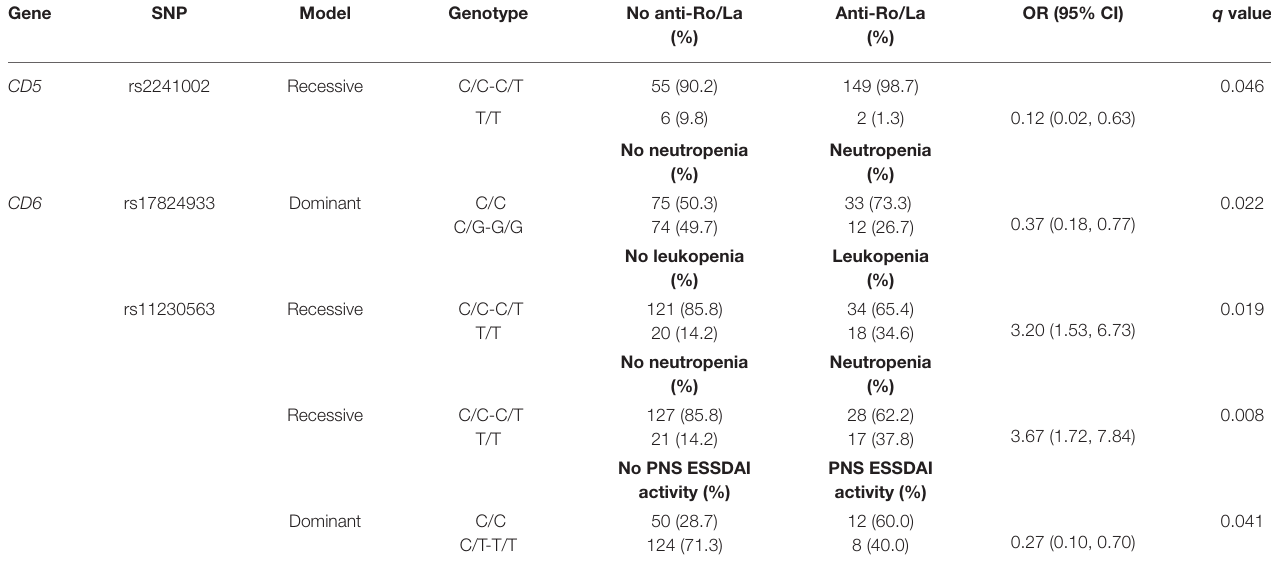
TABLE 3 | Logistic regression analyses of CD5 and CD6 SNPs association with anti-Ro/La antibodies, neutropenia, leukopenia, and peripheral nervous system (PNS) EULAR Sjögren’s syndrome disease activity index (ESSDAI)